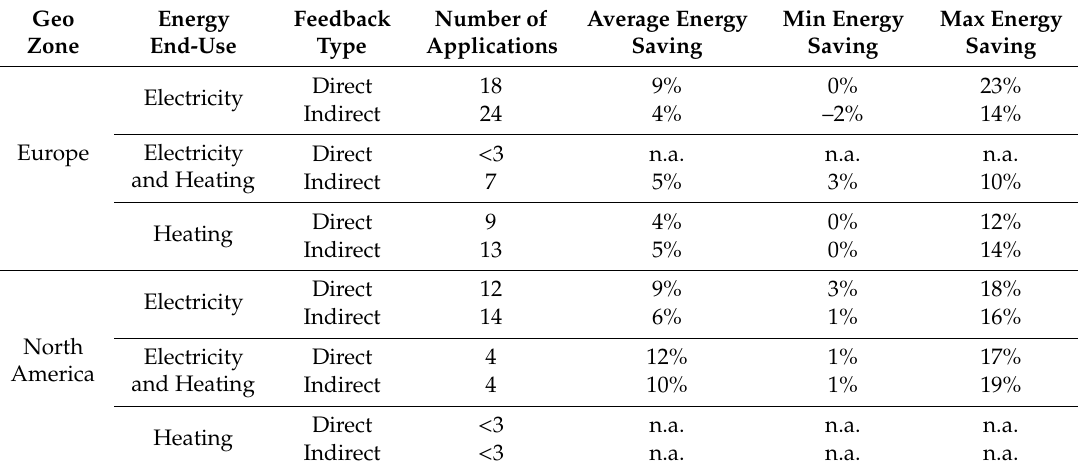
Table 2. Summary of average, minimum, and maximum energy savings related to feedback strategies. Statistics are not provided for categories represented by less than 3